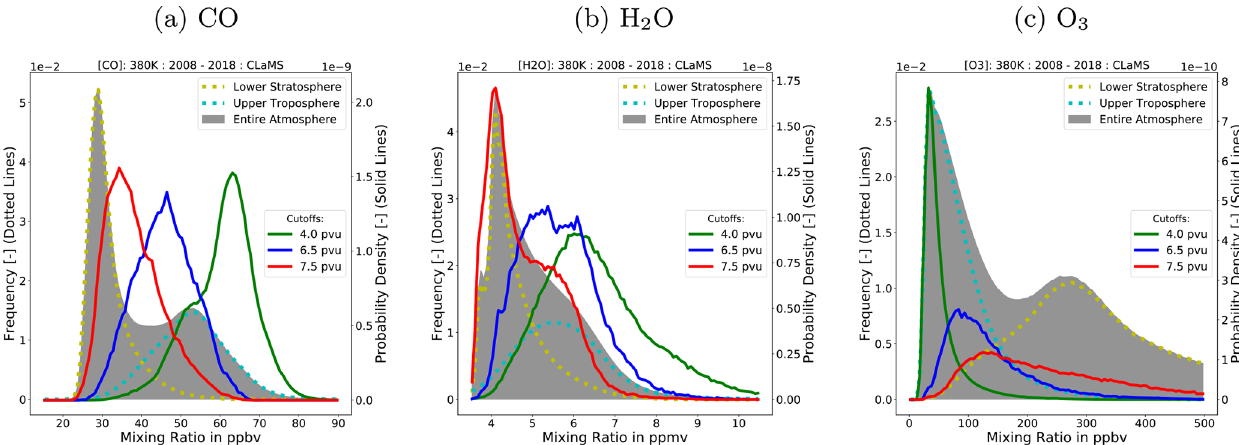
Figure 8. Chemical composition of the ASMA and tropospheric cutoffs at 380K. Shown are histograms and PDFs of the mixing ratio of (a) CO, (b) H 2 O, and (c) O 3 , which are all simulated with CLaMS. The histograms are plotted with dotted lines. The related axis is always on the left. The histograms show the frequency of the mixing ratios within the different spheres of the atmosphere. Additionally, PDFs are shown with solid lines. The related axis is on the right. The probability density shows the frequency of the mixing rations during the different stages of the cutoffs.